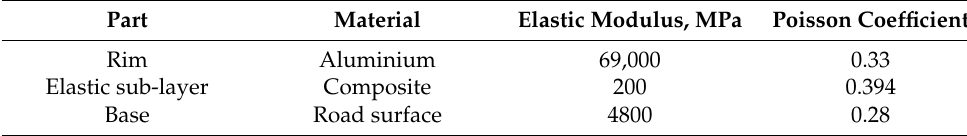
Table 1. Elastic constants of the tyre–road system.